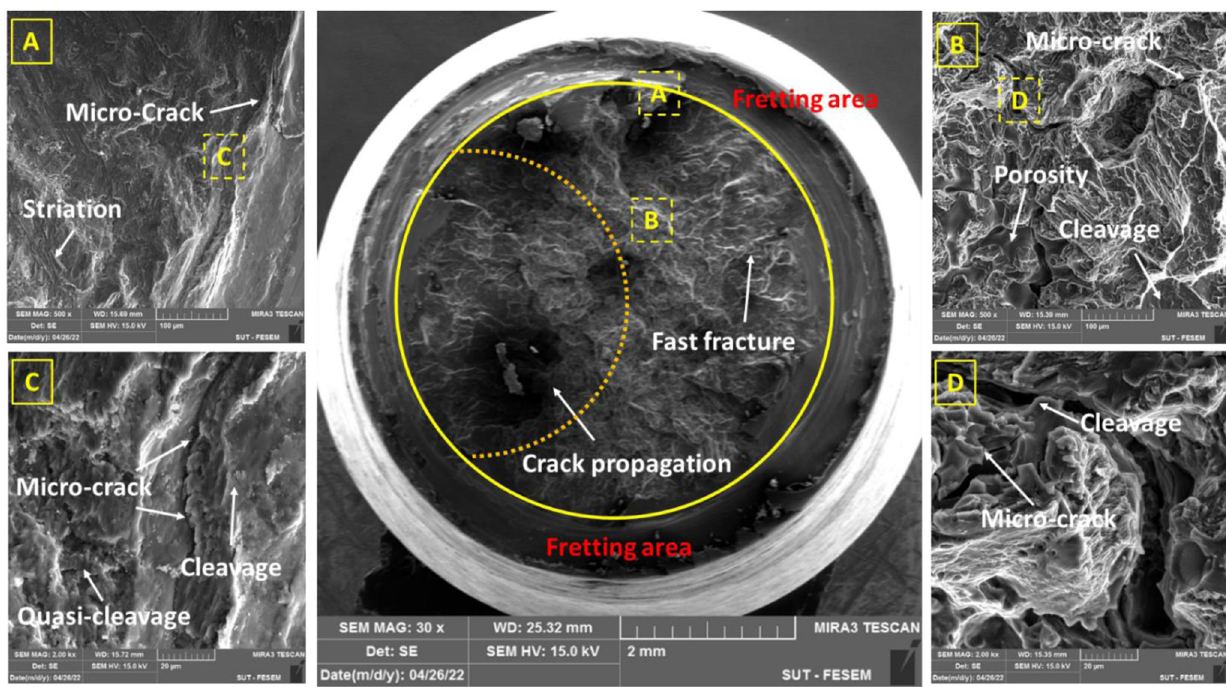
Fig 9. The fracture surface under fretting fatigue conditions (the stress level: 80 MPa).